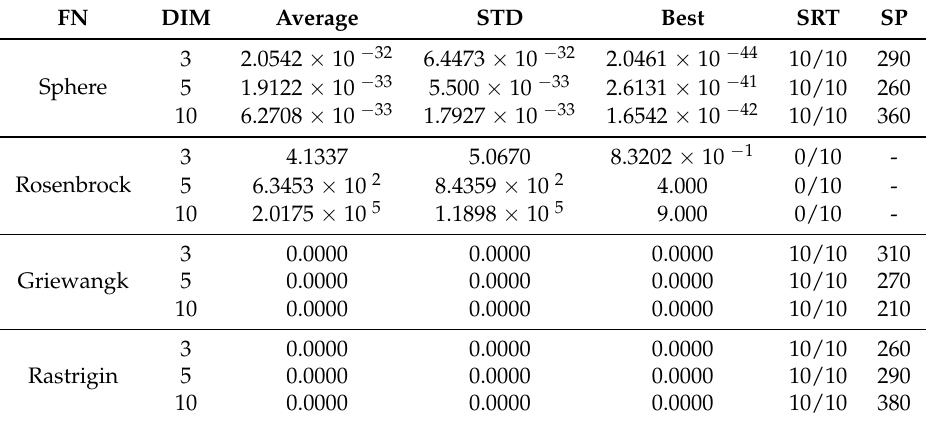
Table 7. Simulation results of the improved CSO (ICSO).